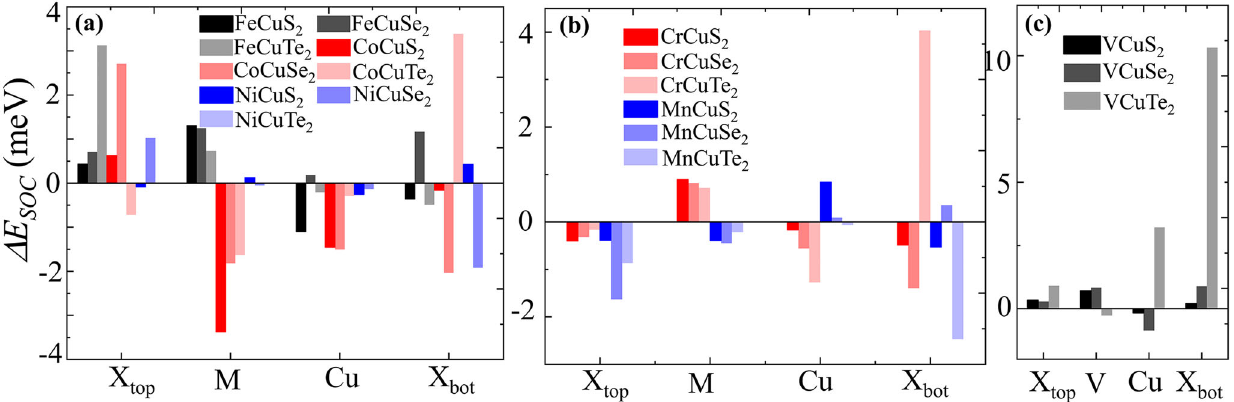
Fig. 3 Anatomy of DMI for M Cu X 2 monolayers. a – c Atomic resolved localization of SOC energy difference between clockwise and anticlockwise chirality for iron/cobalt/nickel ( a ), chromium/manganese ( b ), and vanadium ternary